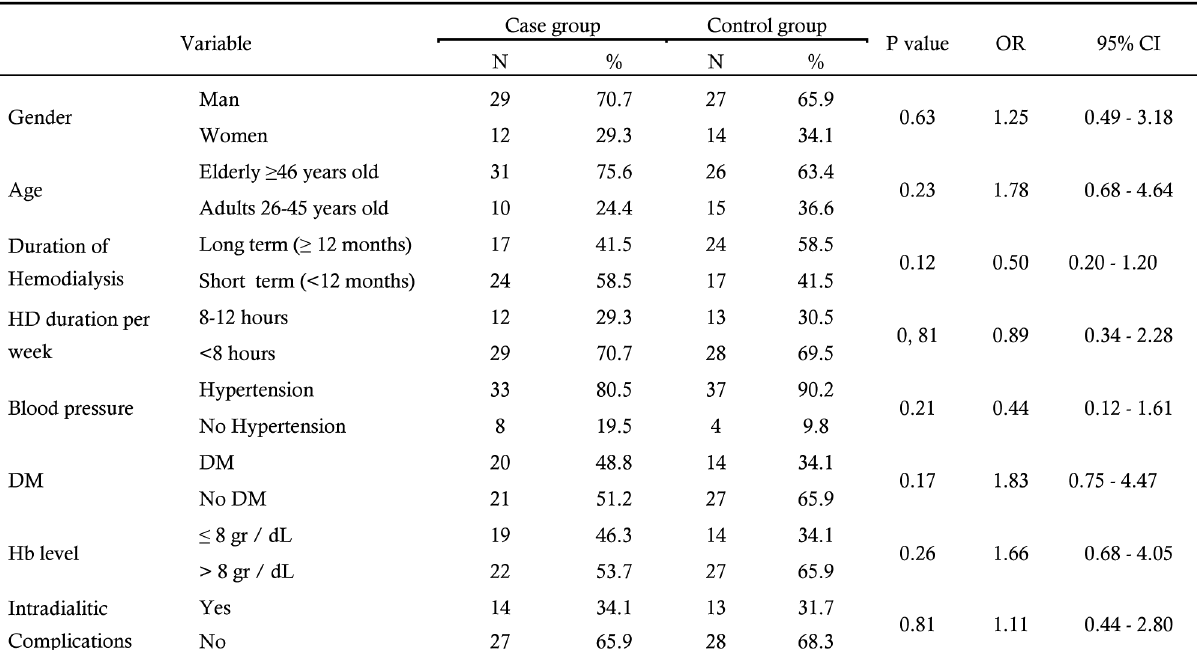
Table 2. Relationship between variables with death of CKD